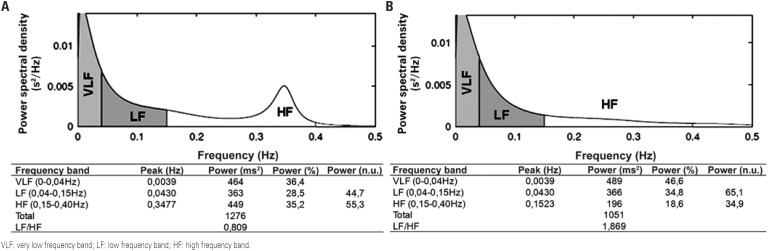
Spectral analysis of frequency using auto regression model, with order model 12 as per Akaike criterion for obese adolescents. Panel A: signal with predominance of parasympathetic modulation; panel B: signal with predominance of sympathetic modulation